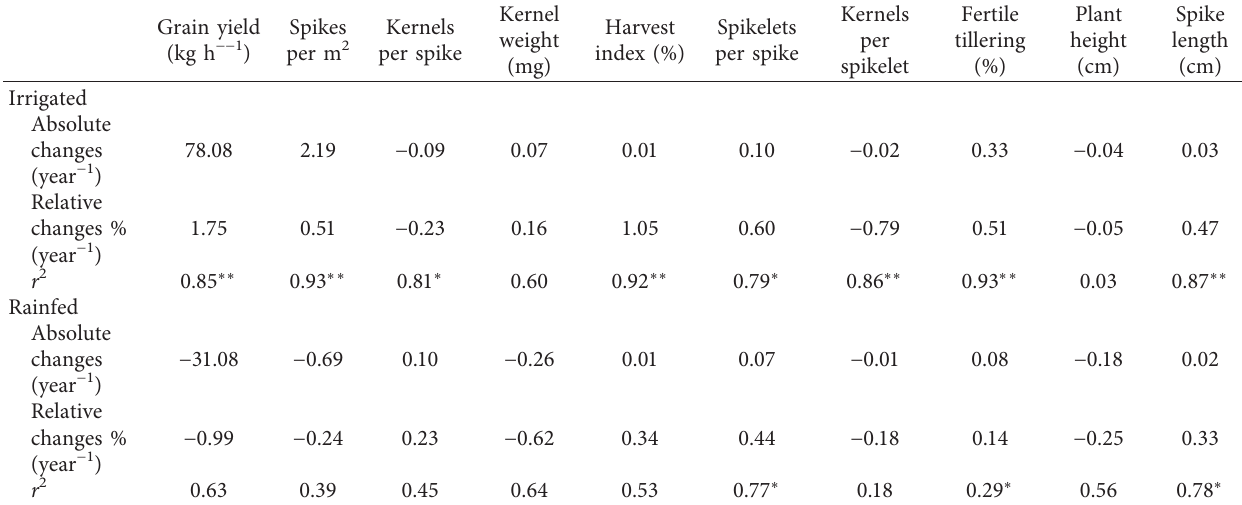
Table 5: Absolute and relative genetic changes in grain yield, spikes per m 2 , kernels per spike, kernel weight, harvest index, spikelets per spike, kernels per spikelet, fertile tillering, plant height, and spike length in six durum wheat varieties grown under two water regimes (irrigated and rainfed) during three growing seasons (2017, 2018, and